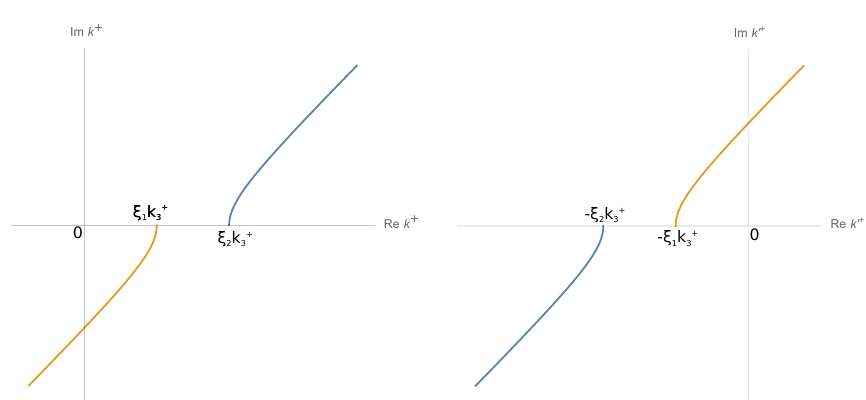
Figure 5 . The branch cuts of the integrand in eq. (3.27) in the complex k + (left panel) and k 0 + (right panel) planes, drawn here for the k +